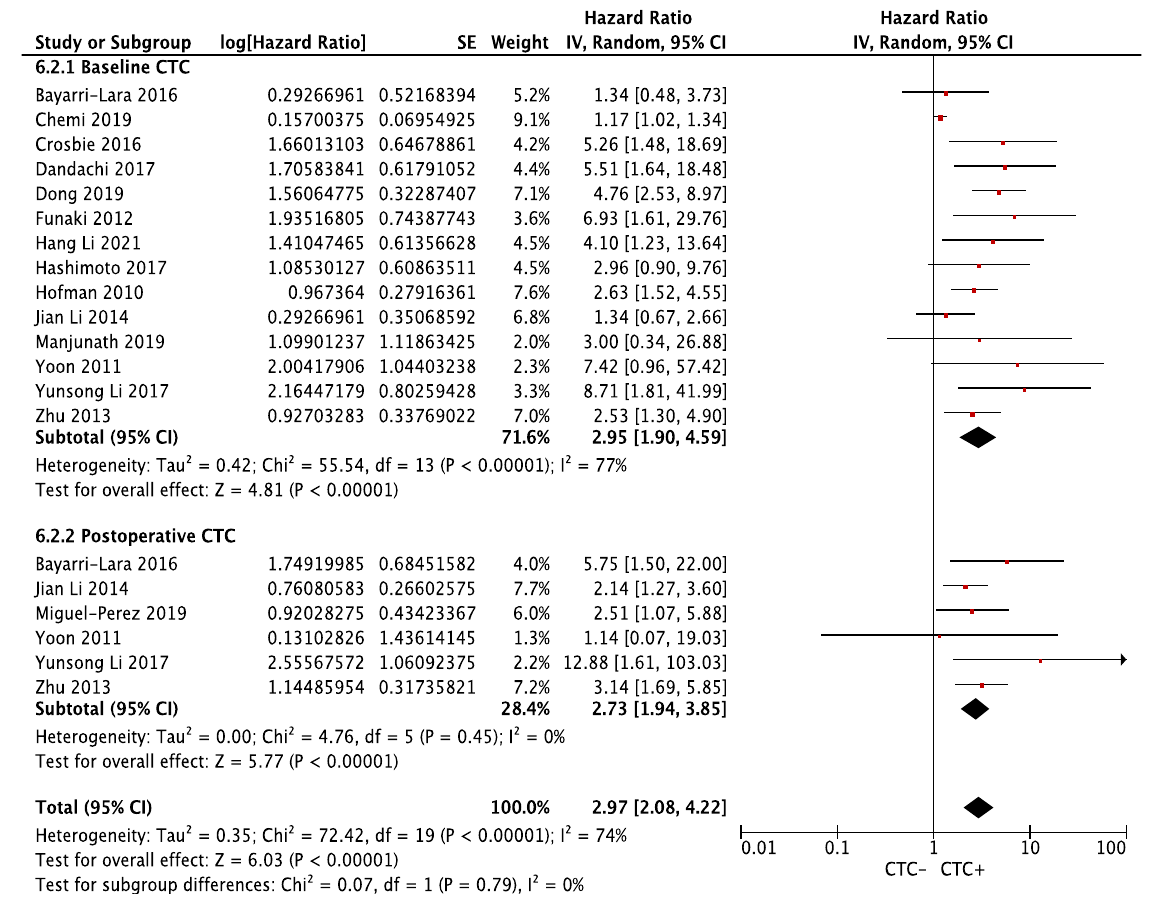
Figure 3. Effect of baseline or postoperative CTC on disease-free survival in resectable NSCLC. Hazard ratios with 95% confidence intervals are displayed by individual studies, describing pooled overall effects for baseline CTC and postoperative CTC, respectively. Abbreviations: HR, hazard ratio; SE, standard error; CI, confidence interval.